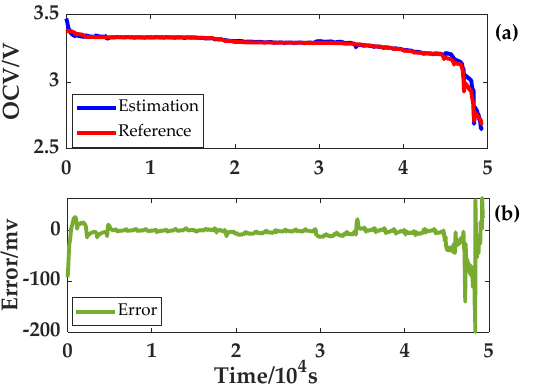
Figure 11. OCV estimation result and estimation error at 45 °C. ( a ) OCV estimation result and ( b )